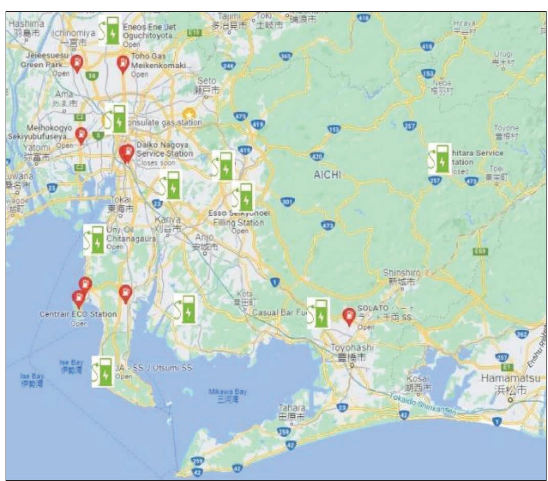
Figure 10: EVCS locations (Model M